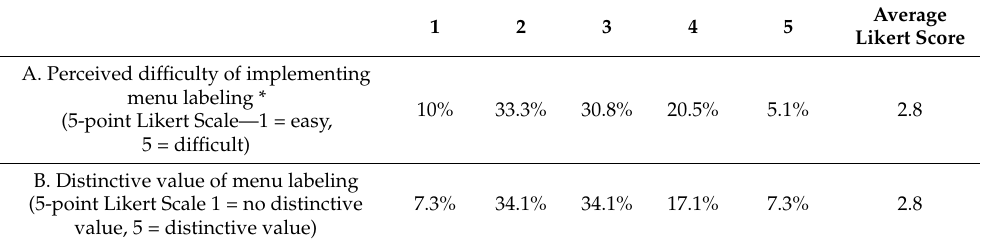
Table 2. Extent to which restaurant owners (n 39) consider it complex to implement menu labeling on their menu (A), and extent to which restaurant owners (n 41) think implementing menu label- ing positively distinguishes them from other restaurants (B). Numbers represent the frequency of restaurant owners who selected the respective degree of respectively complexity and